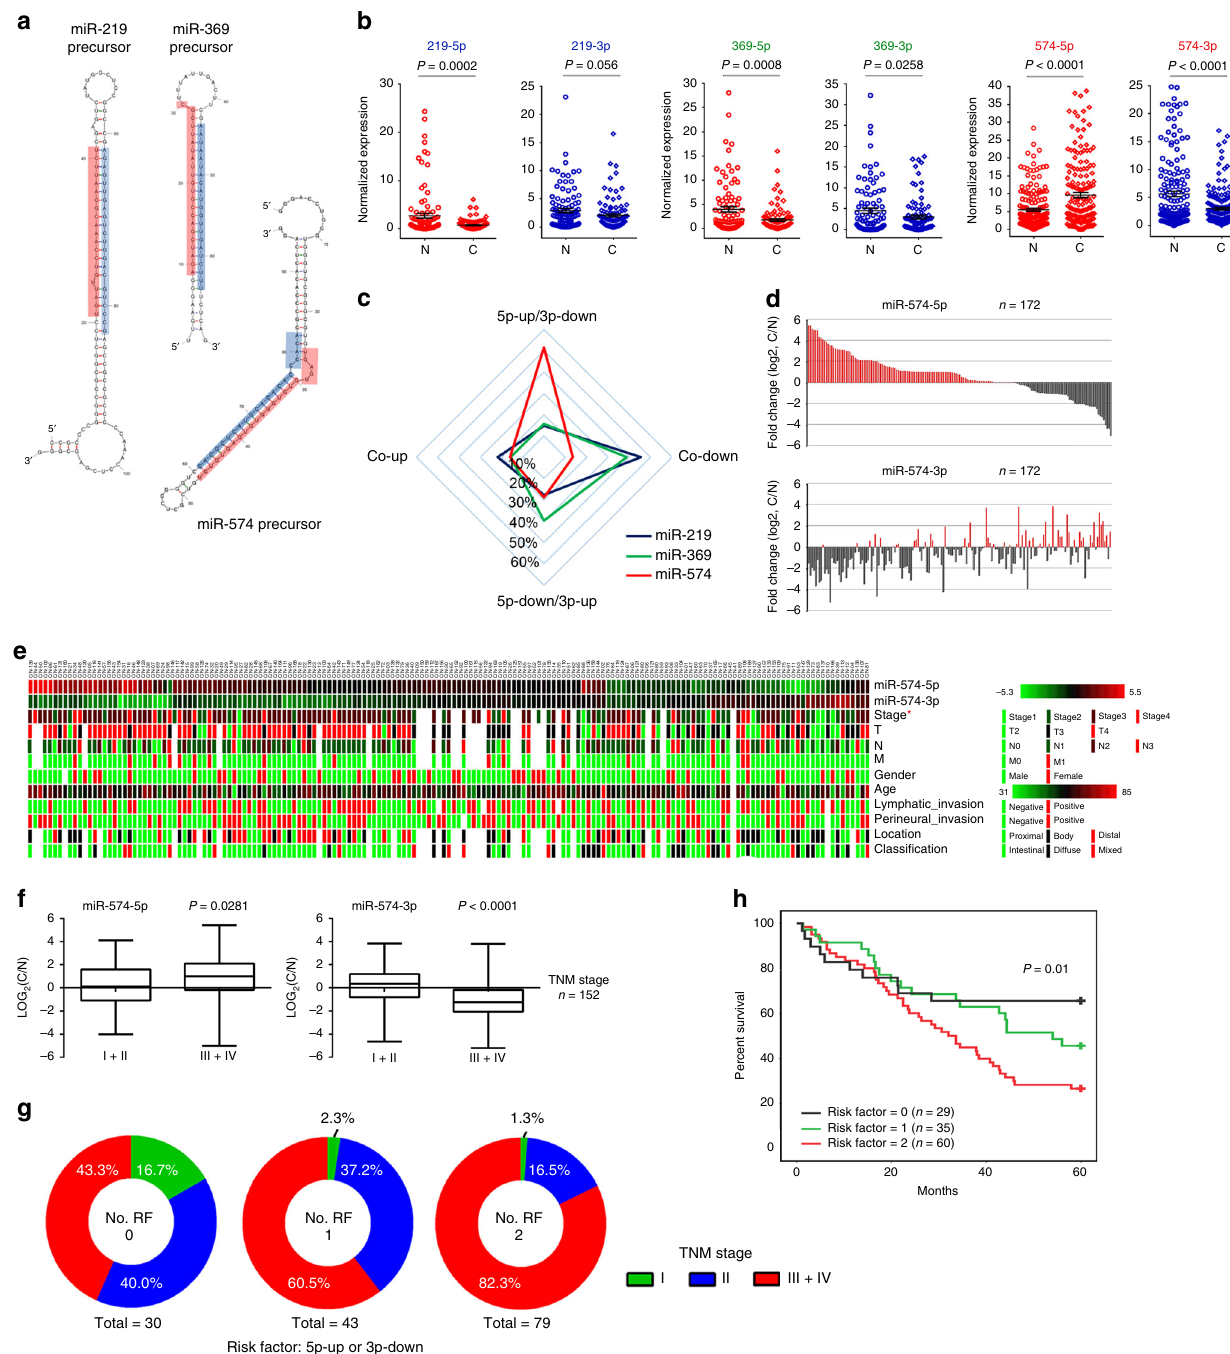
Fig. 1 miR-574-5p and miR-574-3p were reversely expressed in GC patients. a The predicted secondary structure of miR-219, miR-369 and miR-574 precursors. b , c The expression changes of three pairs of miRNA arms: miR-219-5p/-3p, miR-369-5p/-3p, and miR-574-5p/-3p in GC tissues. d The reversed expression of miR-574-5p/-3p in GC patients. e Correlation of miR-574-5p/-3p expression with clinical pathological characteristics of GC patients. f , g Correlation of miR-574-5p/-3p expression with TNM stages of GC patients. The center line indicates the median expression level, bounds of box indicates the interquartile range and whiskers indicates the maximum and minimum value ( f ). A risk factor was de fi ned as miR-574-5p upregulation or miR-574-3p downregulation ( g ). h Kaplan – Meier survival analysis showed the correlation of arm-imbalance of miR-574 with survival rate of GC patients. Data are shown as means ±